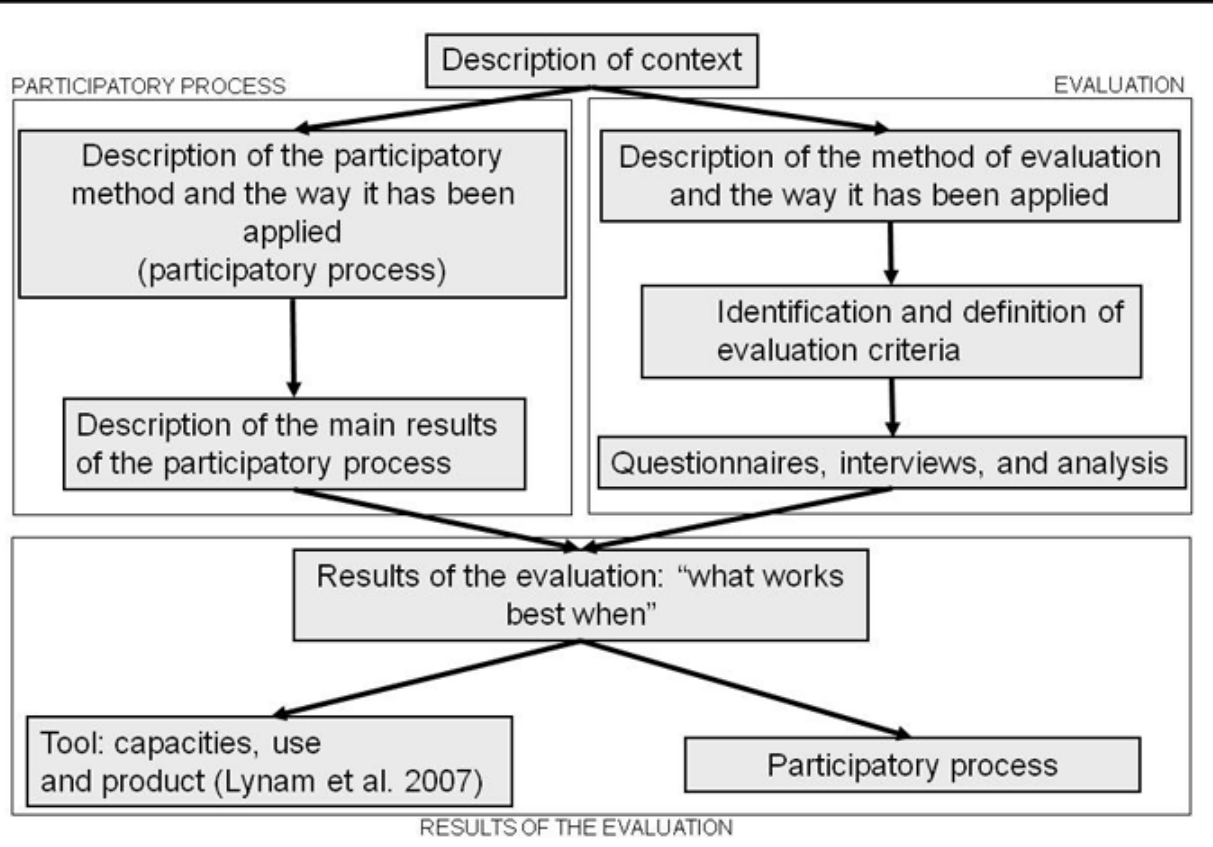
Fig. 1 . Method used for the evaluation of the Bayesian networks participatory process and tool, developed in the Upper Guadiana Basin, following the recommendations of Abelson et al. 2003, Rowe and Frewer 2004, and Von Korff